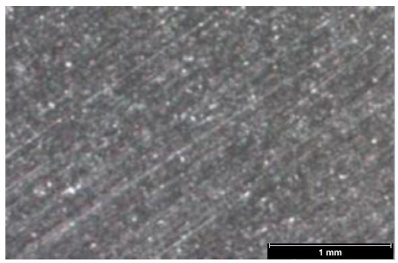
Figure 1. Microscopic image showing surface characteristic of the CrN/NbN coating manufactured by Lafer S.P.A., Piacenza, PC, Italy.